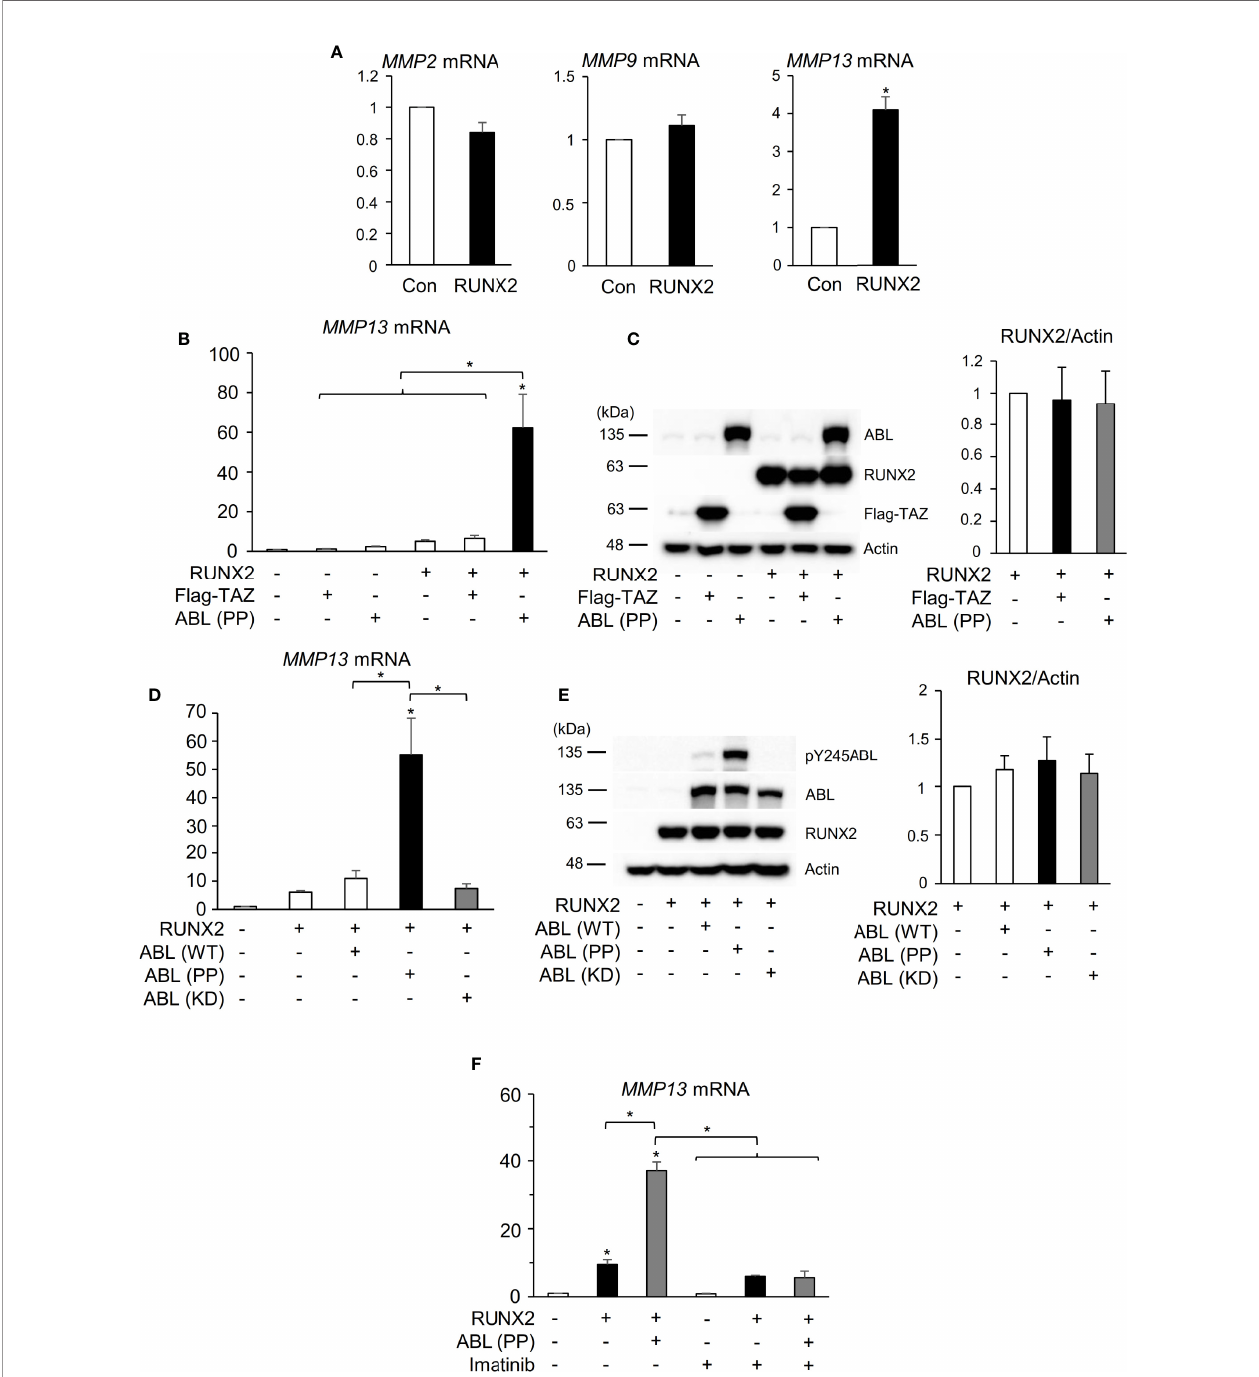
FIGURE 1 | ABL kinase activity is required for RUNX2-mediated MMP13 expression. (A) Quantitative PCR analysis of MMP2, 9, and 13 mRNA expression in HEK293T cells transfected with RUNX2. n = 3. (B) Quantitative PCR analysis of MMP13 mRNA expression in HEK293T cells co-transfected with RUNX2 with or without TAZ or ABL (PP). n = 3. (C) HEK293T cells were co-transfected with RUNX2 with or without TAZ or ABL (PP). Whole cell lysates were probed with the indicated antibodies for Western blot analysis. (D) Quantitative PCR analysis of MMP13 mRNA expression in HEK293T cells co-transfected with RUNX2 with or without ABL (WT, PP or KD). n = 3. (E) HEK293T cells were co-transfected with RUNX2 with or without ABL (WT, PP or KD). Whole cell lysates were probed with the indicated antibodies for Western blot analysis. (F) Quantitative PCR analysis of MMP13 mRNA expression in HEK293T cells co-transfected with RUNX2 with or without ABL (PP) and cultured in the presence or absence of 10 m M imatinib for 24 hours. n = 3. P values were determined by the unpaired t-test (A) or ANOVA with Tukey – Kramer ’ s post hoc test (B – F) . Data are presented as means ± SEM. *P <